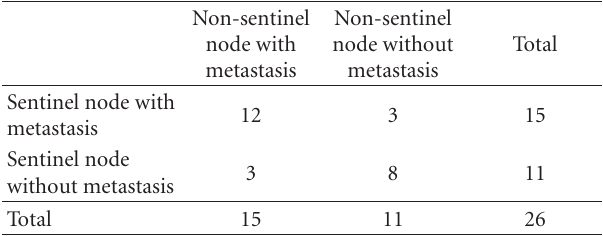
Table 1: Tumor metastasis in sentinel and nonsentinel lymph nodes in patients after neoadjuvant chemotherapy when sentinel nodes were successfully identified ( n =